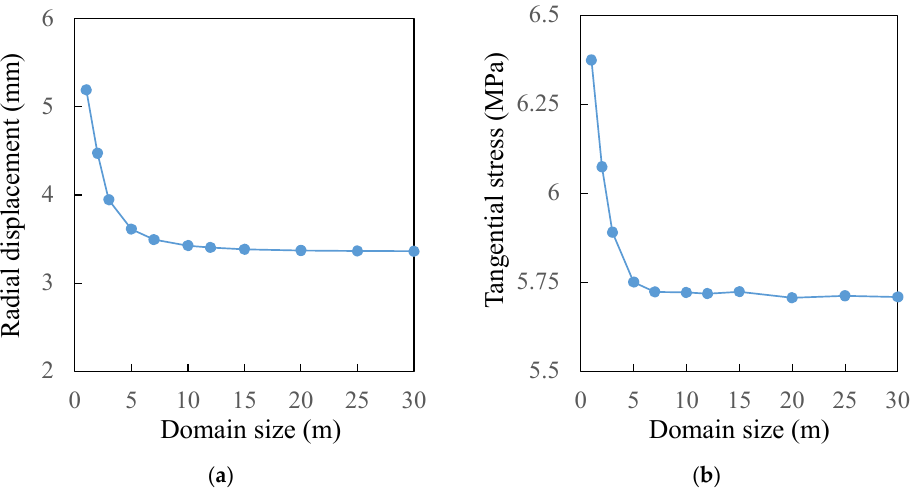
Figure A8. Variations of ( a ) radial displacement and ( b ) tangential stress at point M as functions of domain size.